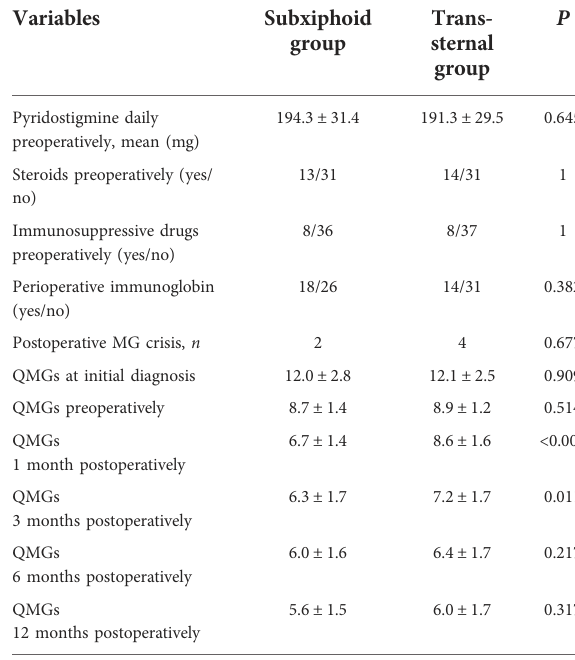
TABLE 2 Comparison of neurological outcomes between subxiphoid approach and trans-sternal approach